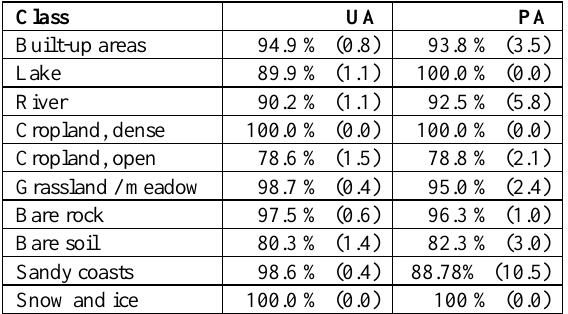
Table 3. User’s accuracy (UA) and producer’s accuracy (PA) for each class (incl. standard errors)